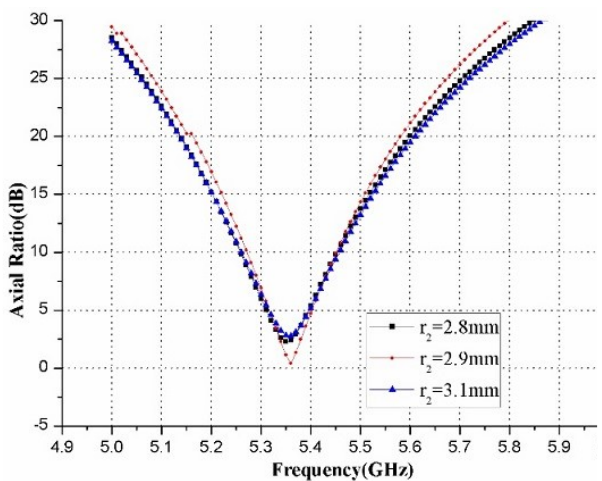
Fig. 4. Return loss for various values of radius r 2 .